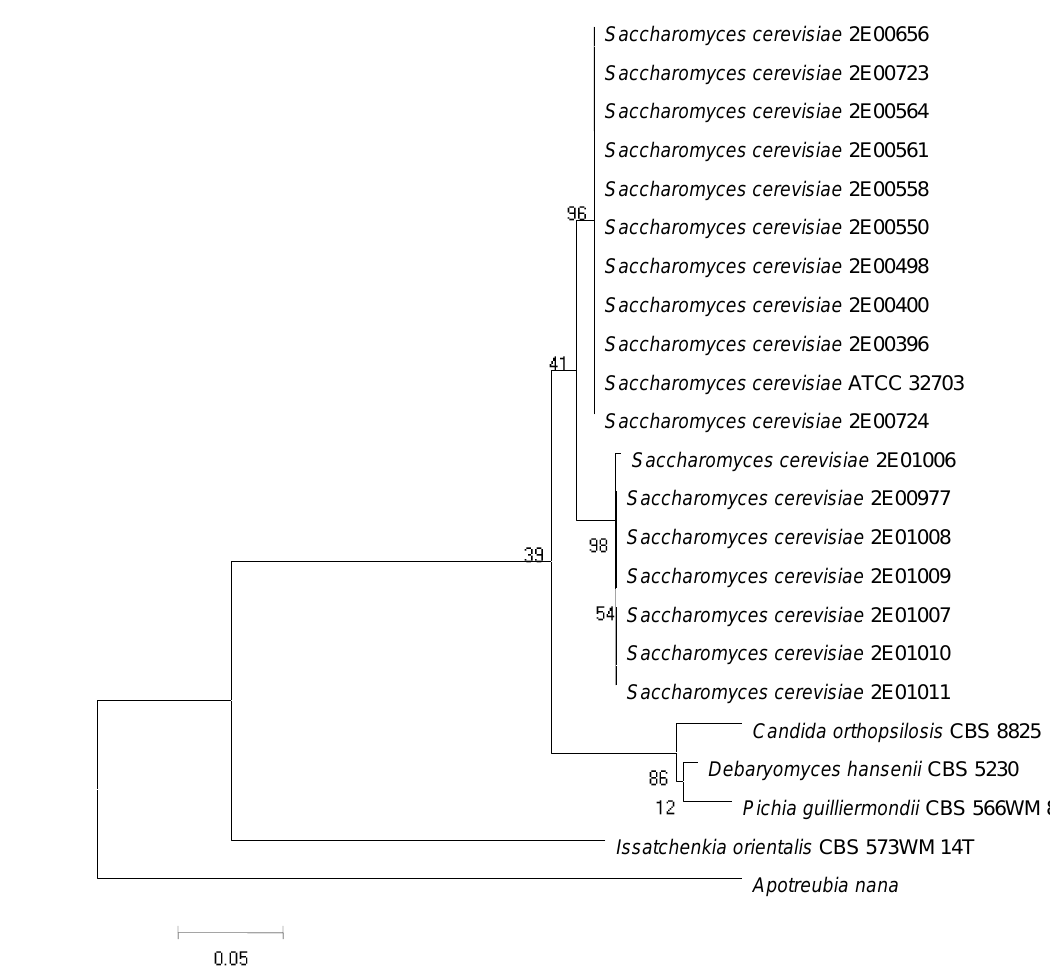
Figure 1. Phylogenetic tree of 17 strains of S. cerevisiae isolated in this study and 13 closest relatives based on a maximum parsimony analysis of D1/D2 26S rDNA sequences. Bootstrap values (1000 pseudoreplications) of ≥ 46%. All the strains shown are type strains and Yarrowia lipolytica was used as the